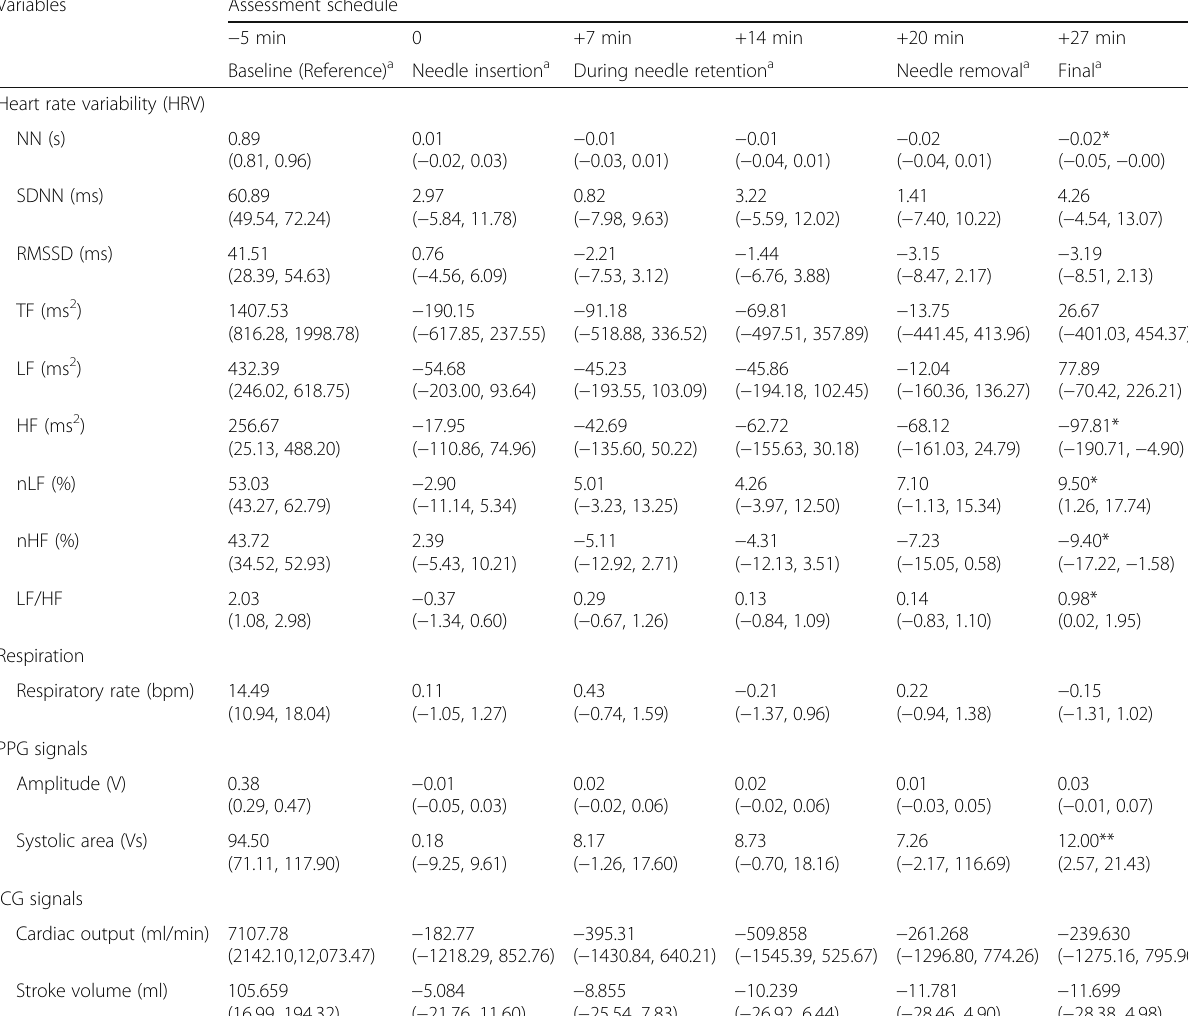
Table 4 Results for the bio-signal variables